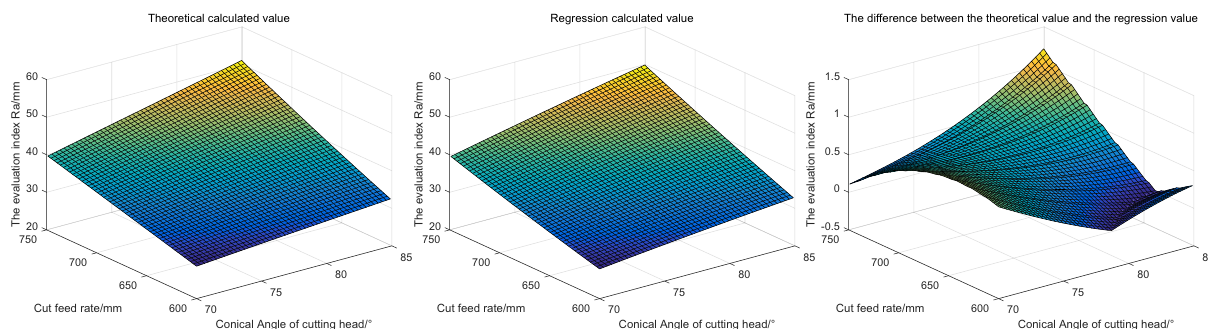
Table 7. Basic parameter setting.